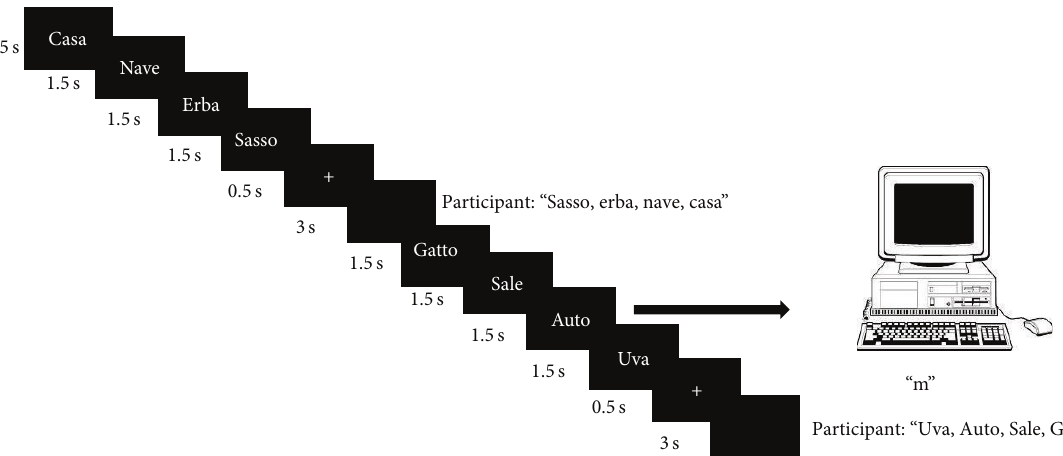
Figure 3: The figure reports two trials of the event-based PM task used in the present study. The first trial does not include a PM target whereas the second does. Each experimental block includes 48 trials. Four of them include a PM target (percentage of PM trials is around 8% of the whole trials). The example reported in the figure is from the experimental block with forward recall as the ongoing task and just one PM target word. In the other experimental blocks varied the order of recall in the ongoing task (forward versus backward) and/or the number of PM target words (1 versus